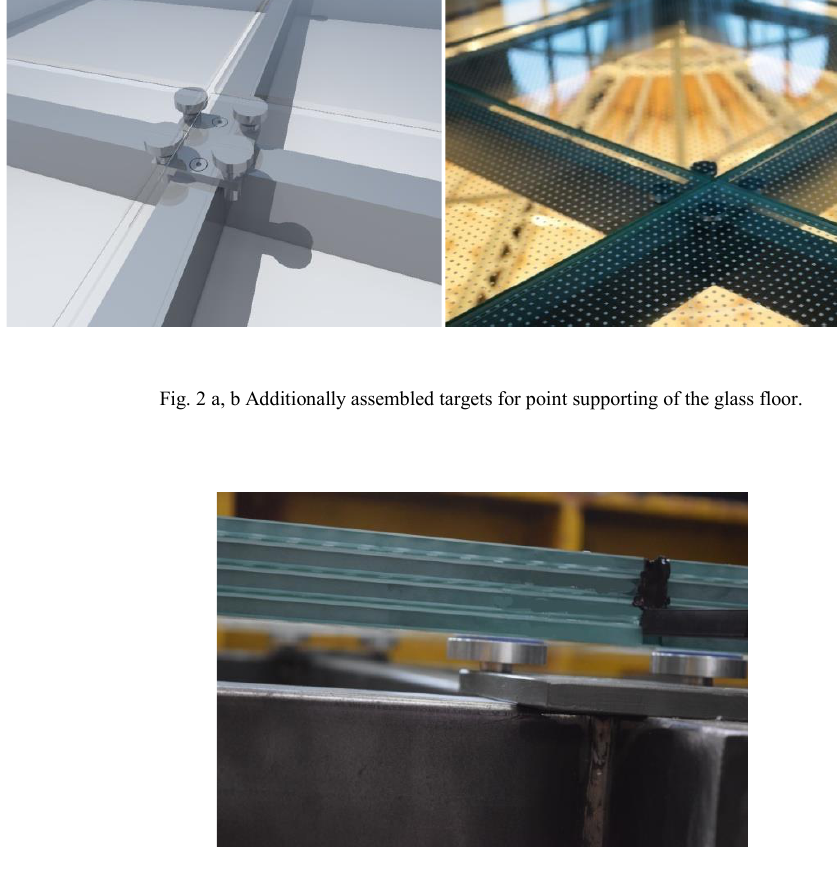
Fig. 3 Side view of the corner plate with local